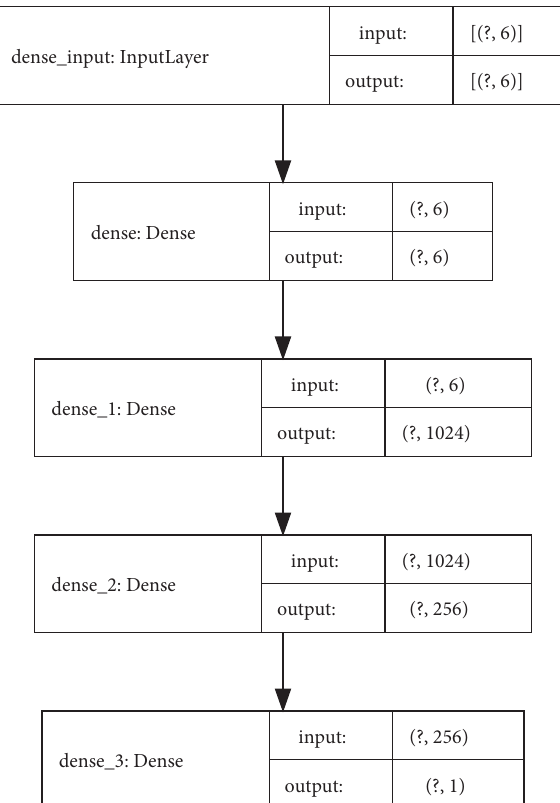
Figure 6: NAS method architecture for training data.